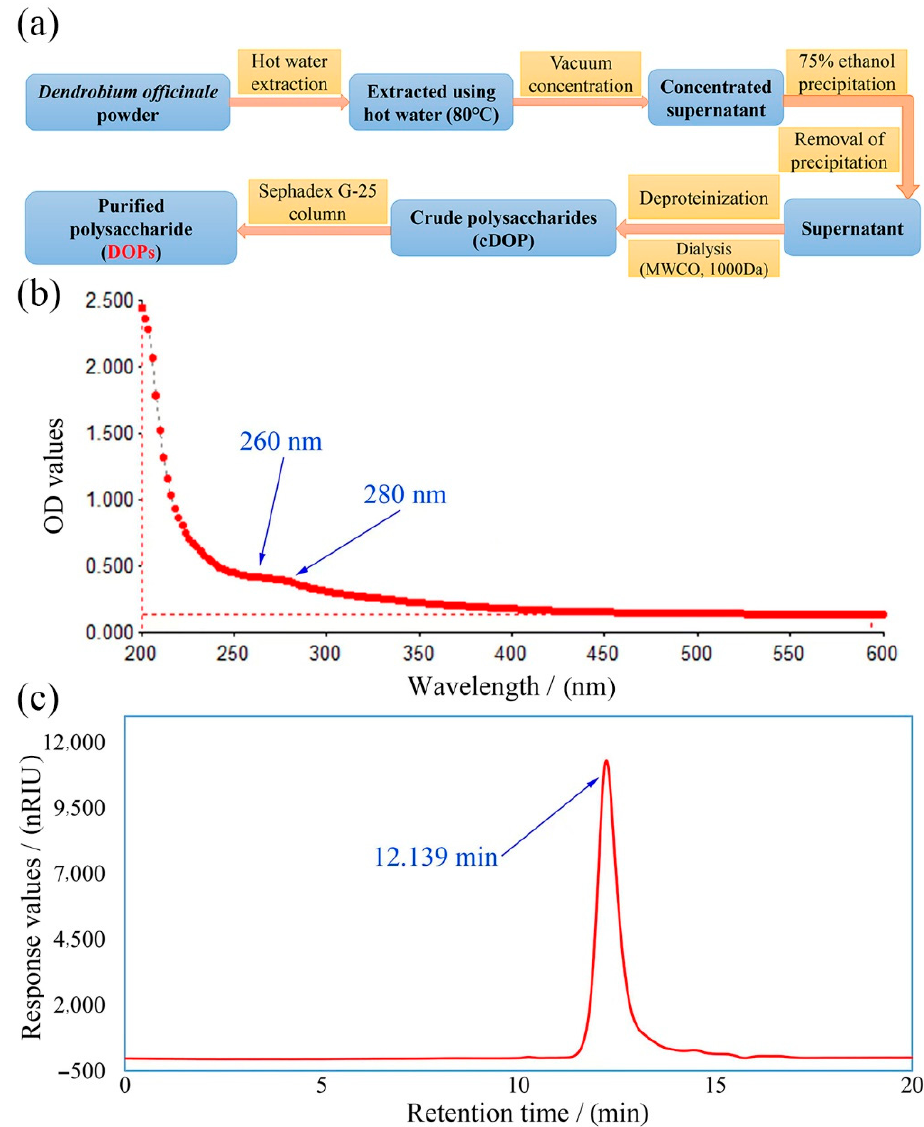
Figure 1. The flow diagram of extraction and purification process for DOPs ( a ); UV-vis spectrum ( b ) and HPGPC profile ( c ) in DOPs.